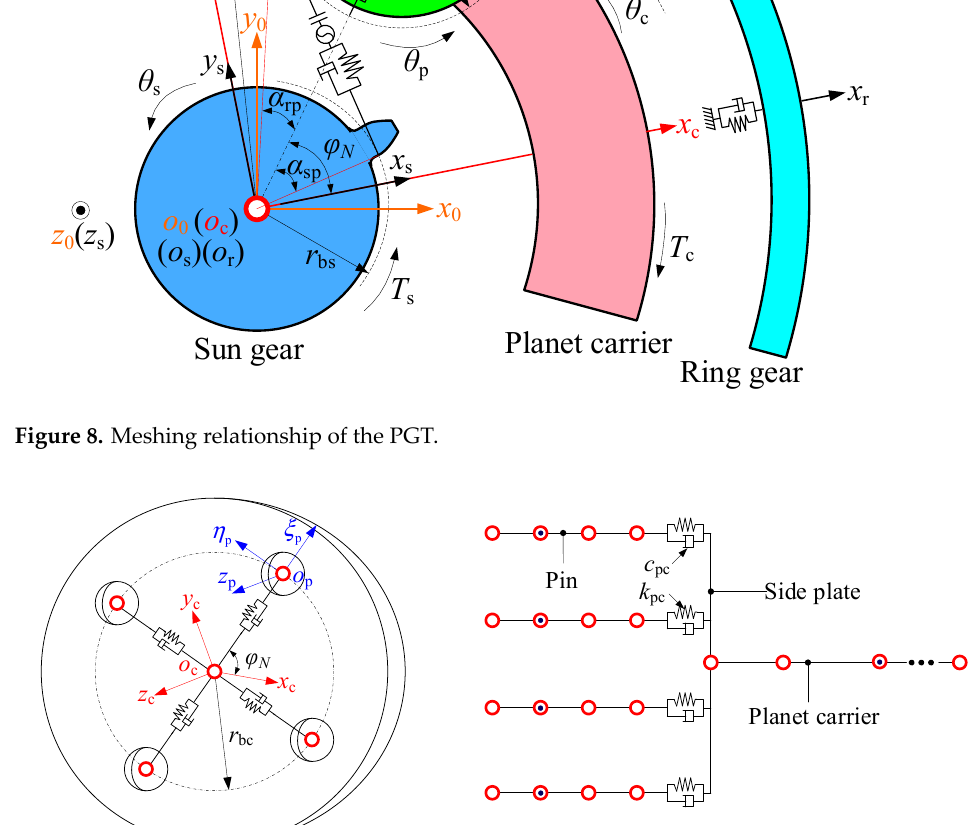
Figure 9. Spatial coupling relationship between pin and side plate.